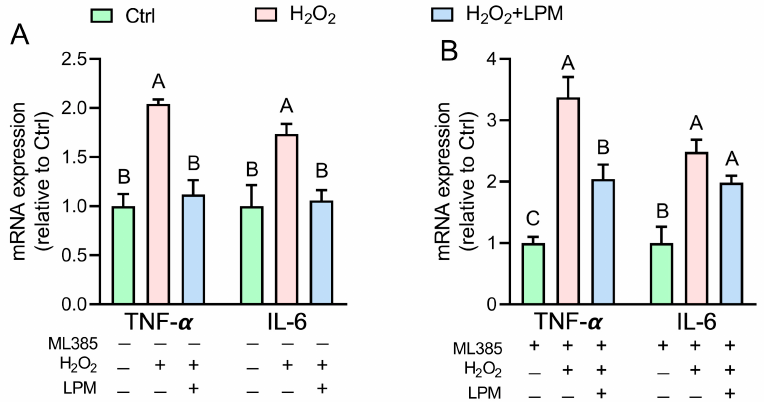
Figure 7. E ff ects of L. plantarum metabolites (LPM) on the mRNA expression of tumor necrosis fac- tor- α (TNF- α ) and interleukin-6 (IL-6) in H 2 O 2 -treated HepG2 cells without ( A ) or with ( B ) pretreat- ment of ML385. Data represented as mean ± SEM of 3 measurements. Groups not sharing a common le tt er are signi fi cantly di ff erent ( p ≤ 0.05).